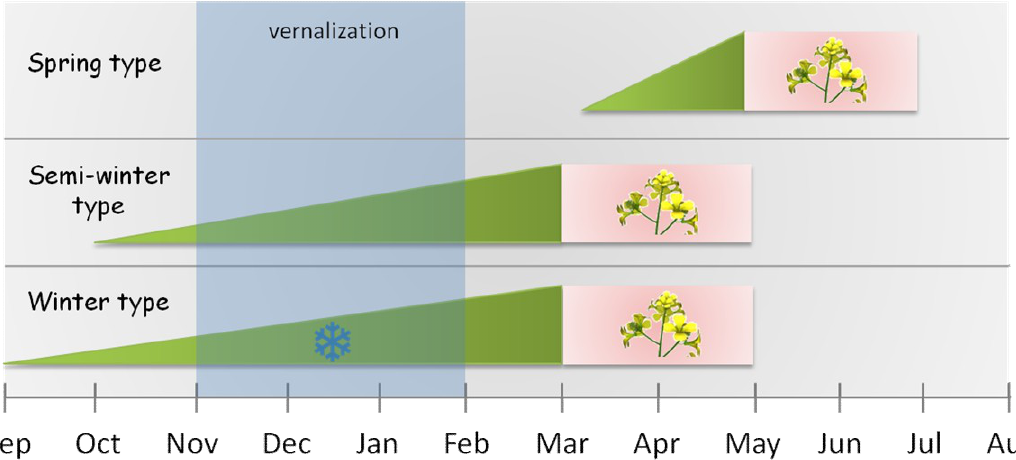
Figure 2. Schematic representation of the life cycles of annual Brassica species. Green triangles represent vegetative growth, pink boxes plant flowering. Periods of cold required for vernalization are indicated by a blue box. Frost symbols indicate frost hardiness in winter types that does not occur in semi-winter plants.